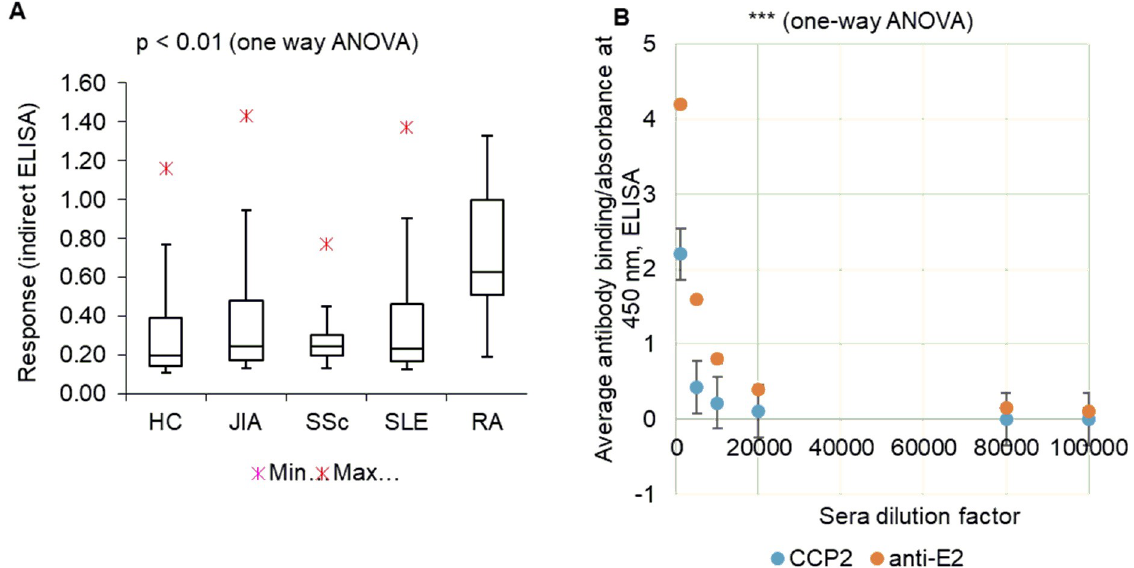
Fig 4. Clinical (A) and analytical (B) sensitivity study of anti-E2 test vs controls. HC = healthy control, JIA = juvenile idiopathic arthritis, SSc = systemic sclerosis, SLE = systemic lupus erythematosus, RA = rheumatoid arthritis. (B) Mean reactivity for 20 samples at onset is given.